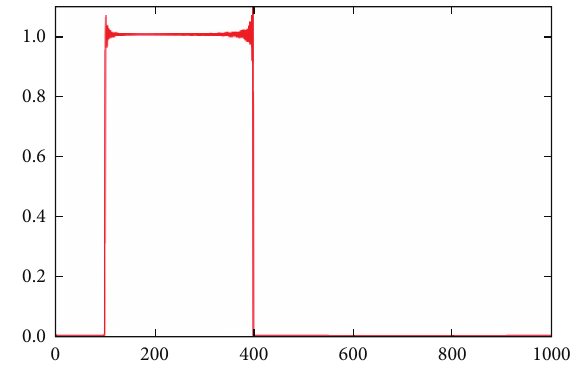
(⋅) of a Zeno input 𝑖−1 ,𝑡 𝑖 )